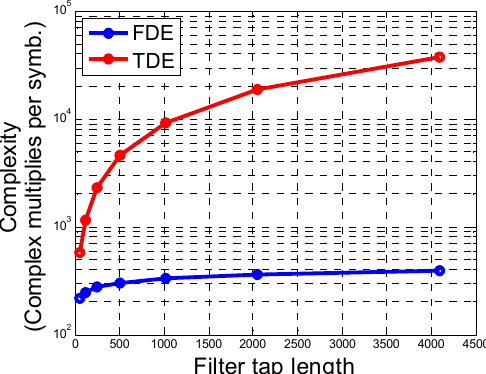
Figure 14. Complex multiplies per symbol vs. filter tap length.